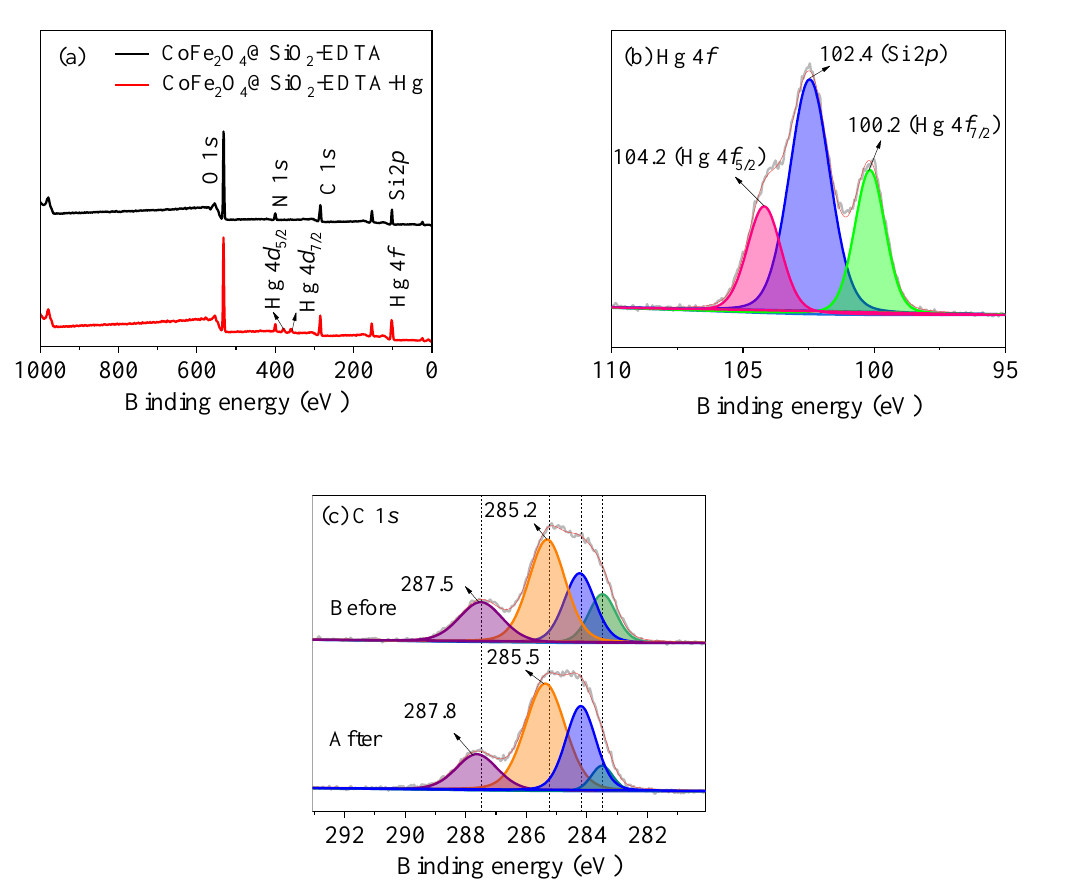
Figure 16. XPS spectra of survey scan of ( a ) and high-resolution scan of Hg 4 f ( b ) and C 1 s ( c